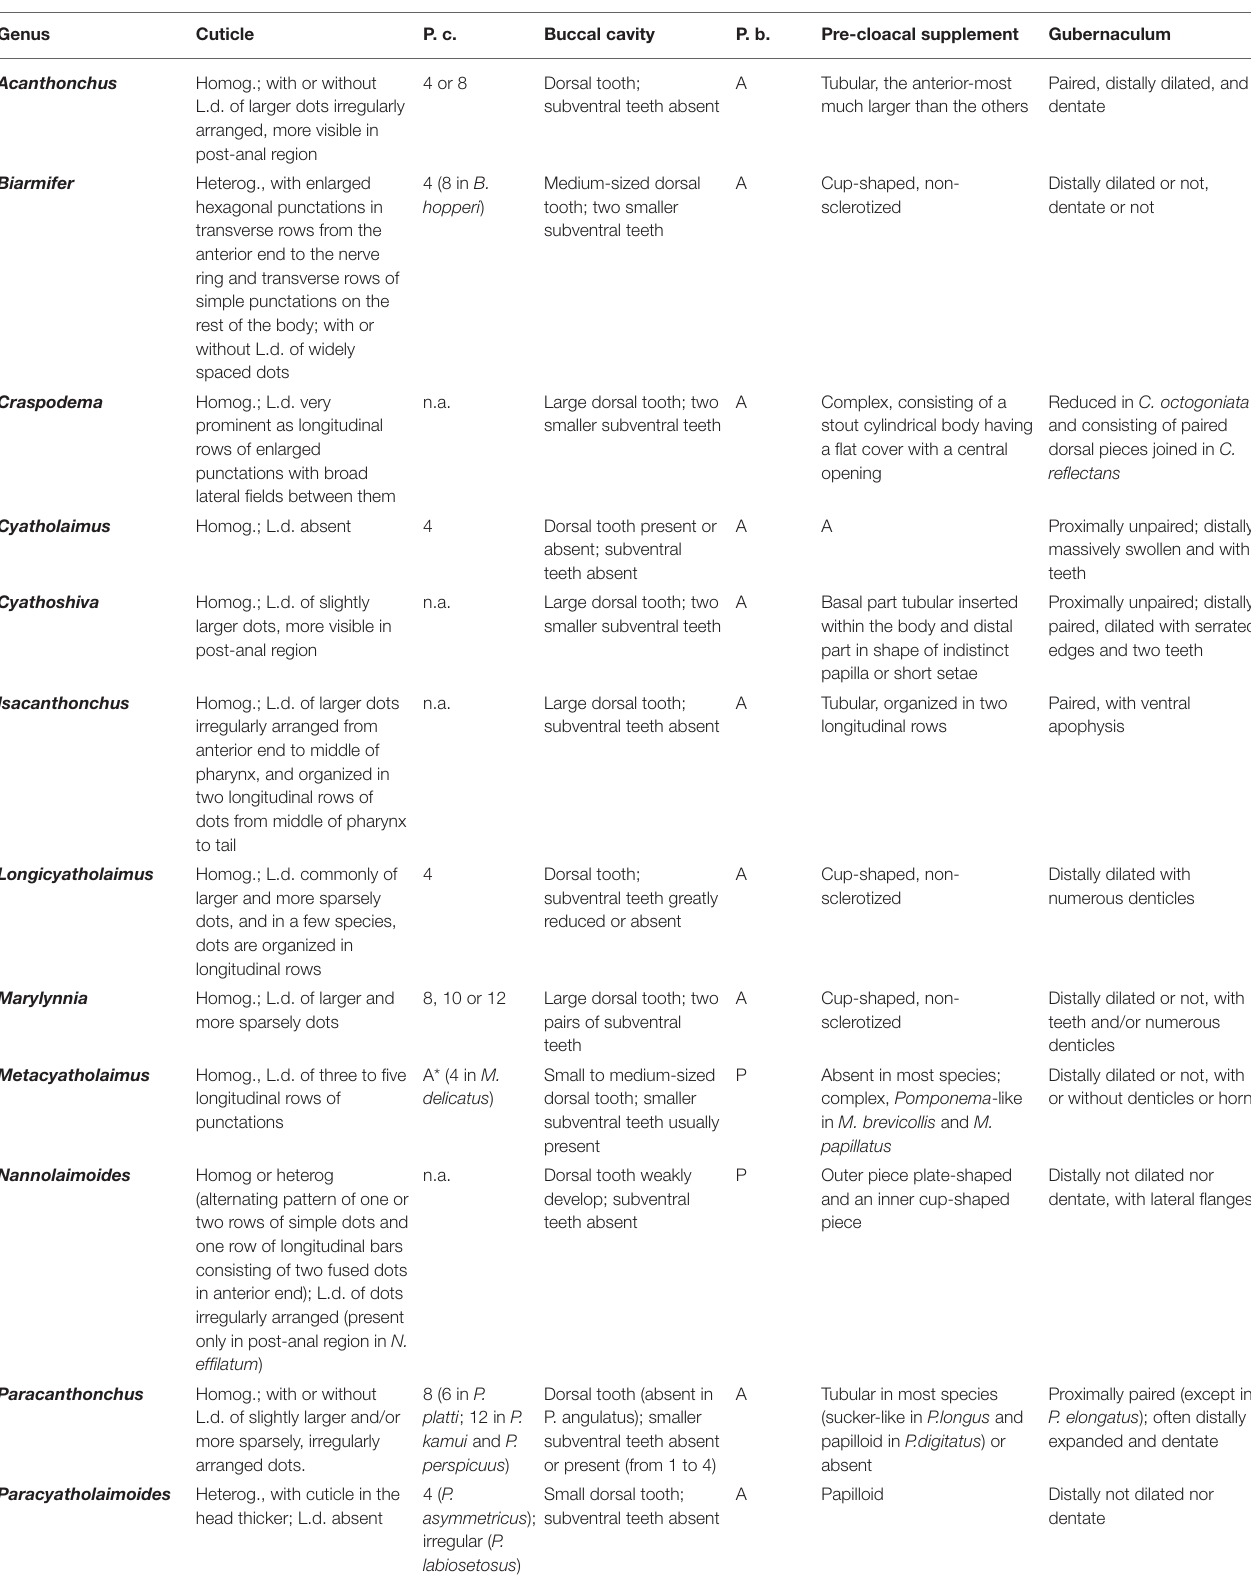
TABLE 1 | Diagnostics characters for Cyatholaimidae genus